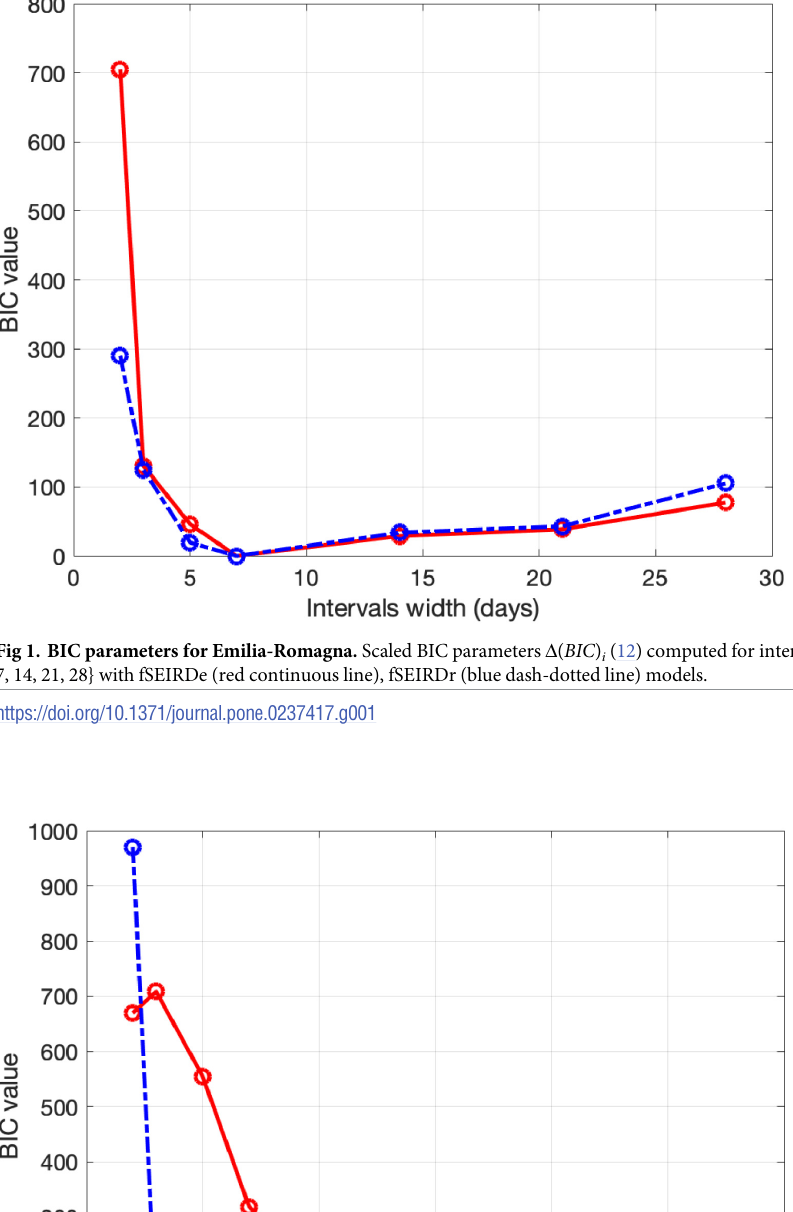
Fig 2. BIC parameters for Lombardia. Scaled BIC parameters Δ ( BIC ) 21, 28} with fSEIRDe (red continuous line), fSEIRDr (blue dash-dotted line) models.